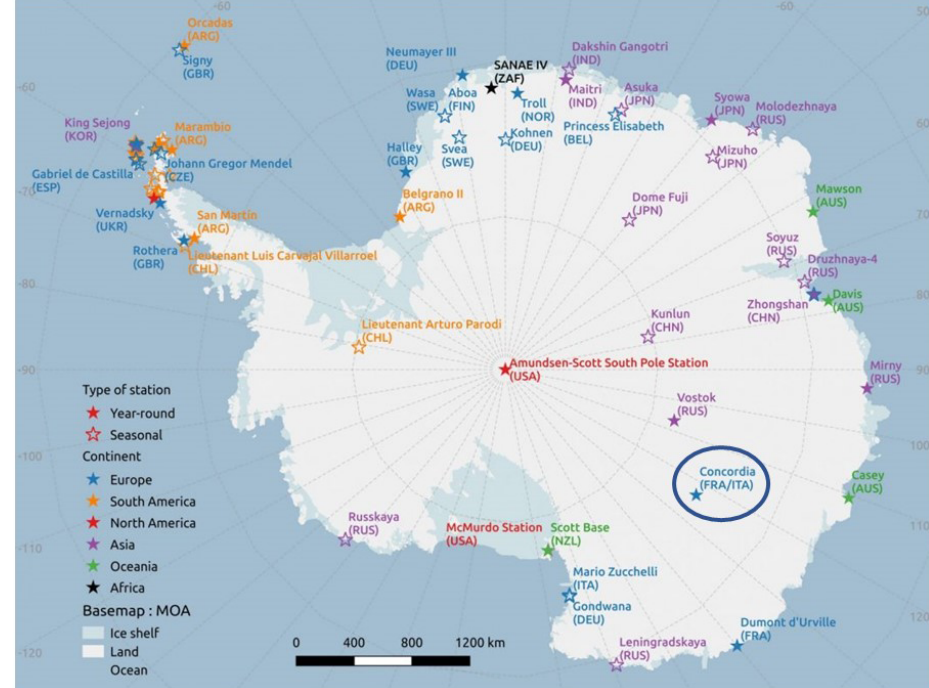
Figure 1. The map shows the main research stations in